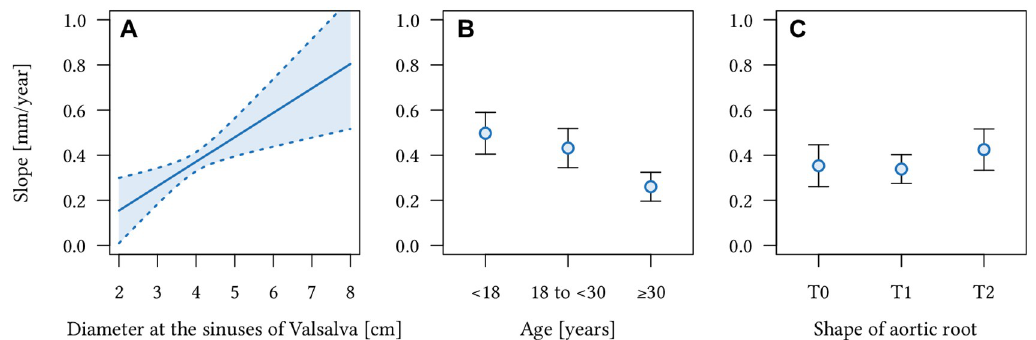
Fig 3. Effect plots with 95% confidence intervals for adjusted growth rates of absolute aortic diameters at the level of the sinuses of Valsalva in 111 Marfan patients. Results of multivariate regression with (A) diameter at baseline, (B) age and (C) shape of aortic root as dependent variables and adjusted growth rate of aortic diameters as outcome variable. Larger aortic root diameter at baseline (A) and younger age (B) are significantly associated with higher adjusted growth rates of the aortic root at the level of the sinuses of Valsalva. (C) There is no significant association between the shape of the aortic root (T0, T1, or T2) and the adjusted aortic growth